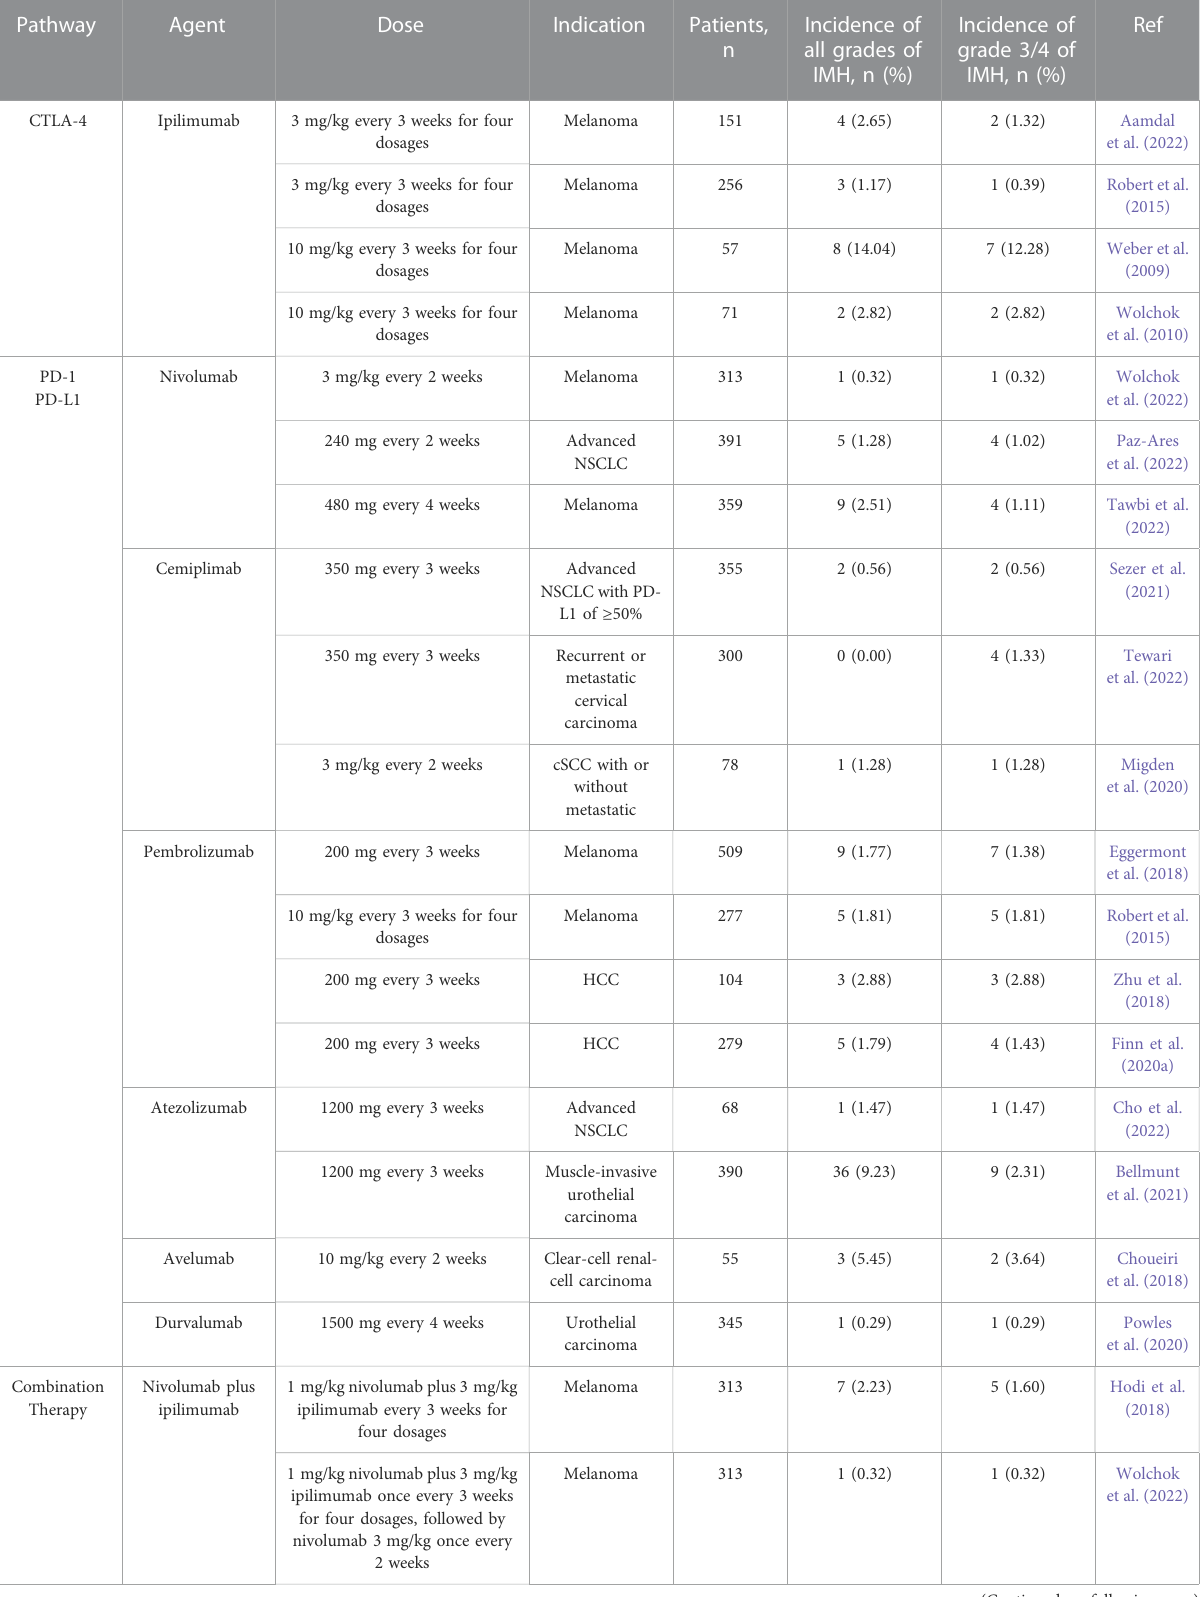
TABLE 2 Incidence of immune-mediated hepatitis according to different treatment regimens with immune checkpoint inhibitors.